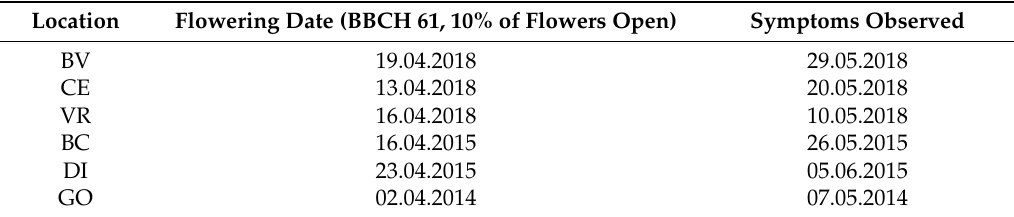
Table 3. Dates of apple flowering and observations of first symptoms of fire blight. BBCH, Biologische Bundesanstalt, Bundessortenamt and